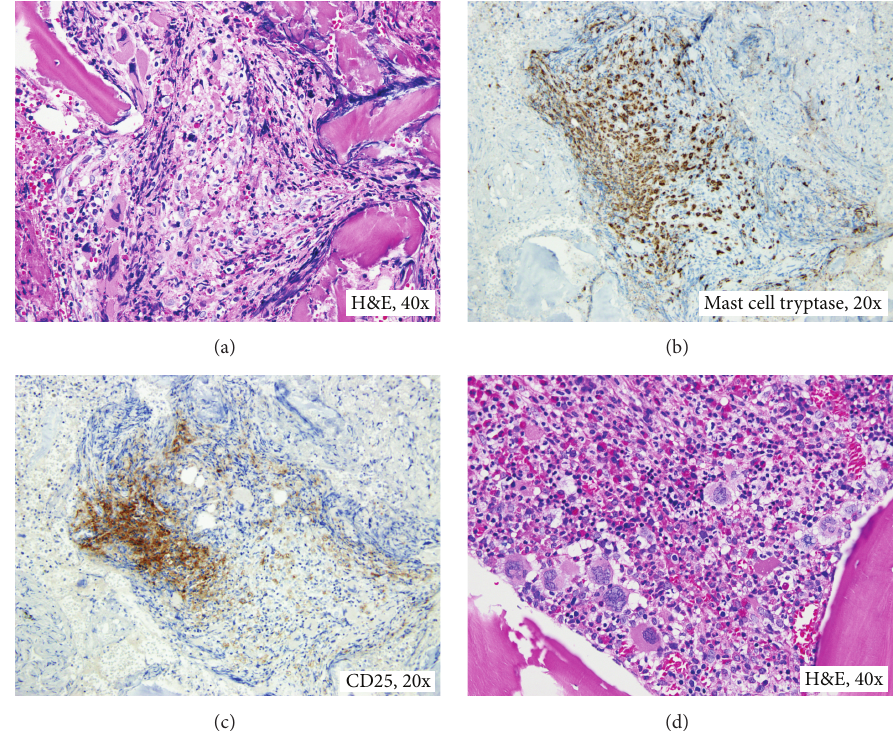
Figure 1: Bone marrow biopsy. (a) Large cluster of mast cells; (b) cluster of mast cells with positive immunohistochemical staining for mast cell tryptase; (c) cluster of mast cells with positive immunohistochemical staining for CD25; and (d) clusters of atypical megakaryocytes.